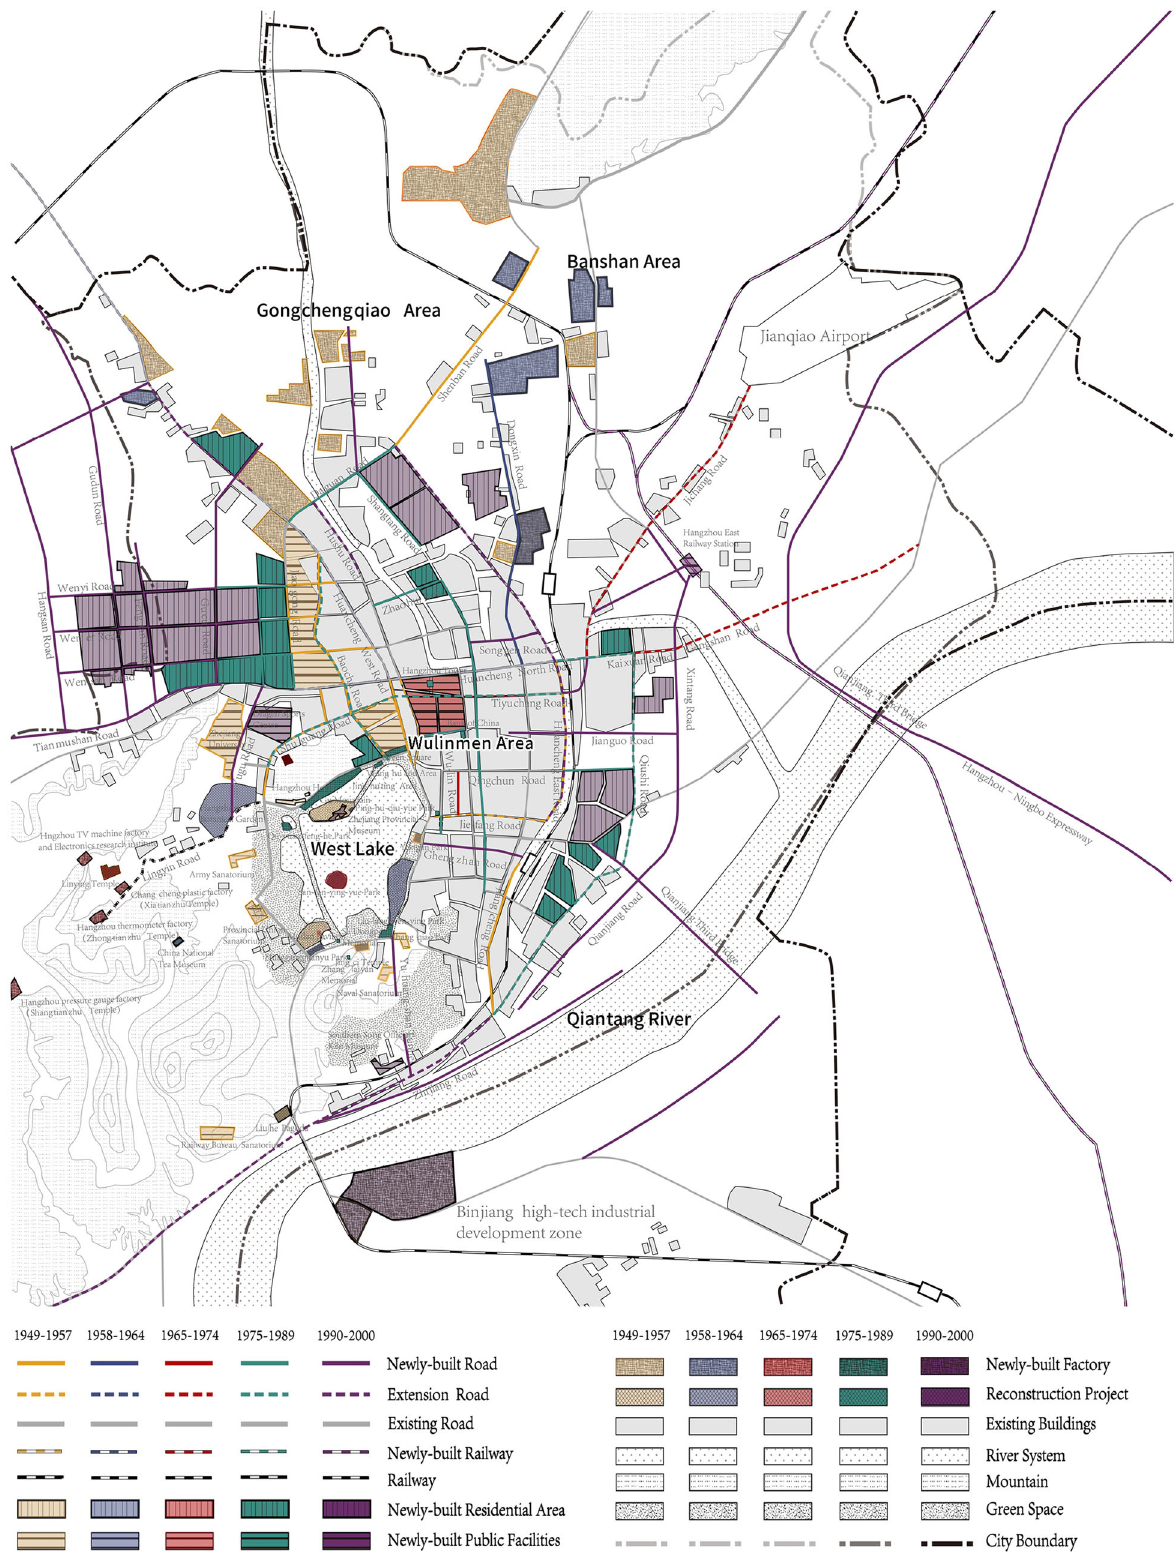
Fig. 2 New Constructions and Renewal Projects of Five Stages (Source: the authors. Data are from the Hangzhou Yearbook and Hangzhou Construction